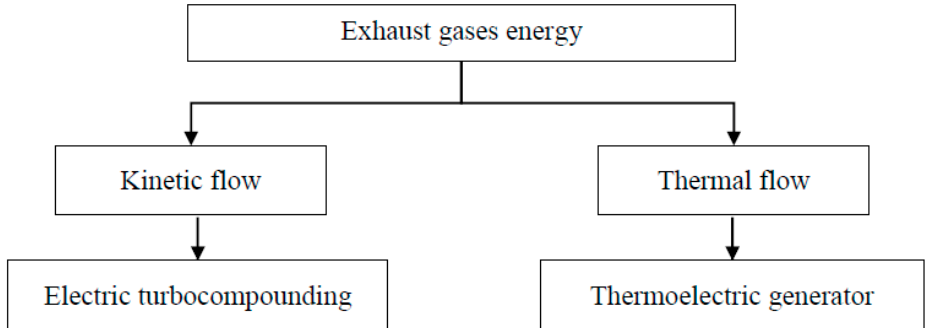
Figure 7. The principle methods for exhaust gas recovery. Source: developed by authors.